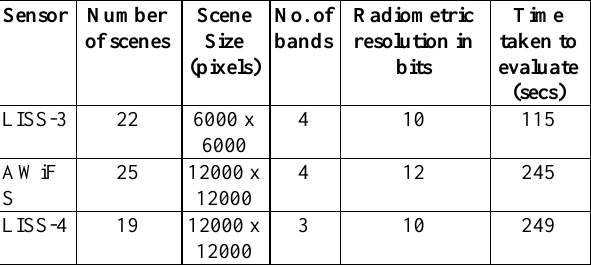
Table 3. Time taken to evaluate the data